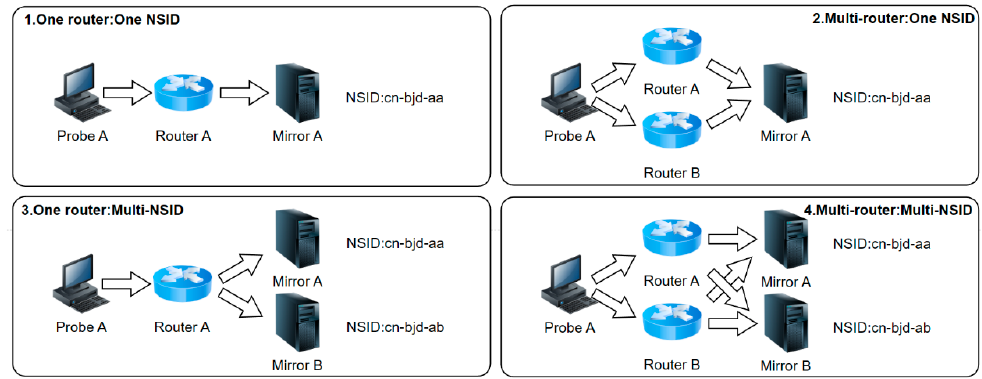
Figure 2. The correspondence between the router and NSID.